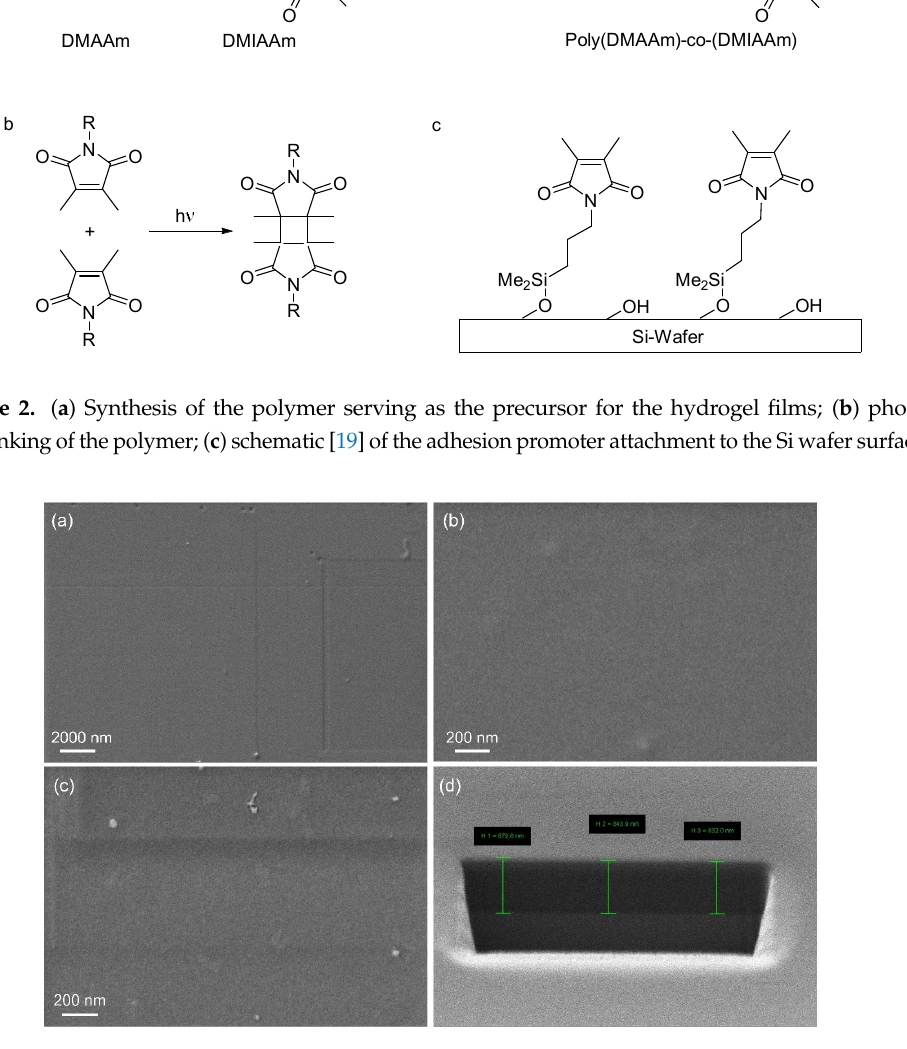
Figure 1. SEM images of dry hydrogel films prepared by spin-coating with variable polymer concentration and spin velocity (average film thicknesses: ( a ) 0.187 µ m; ( b ) 0.588 µ m; ( c , d ) 0.851 µ